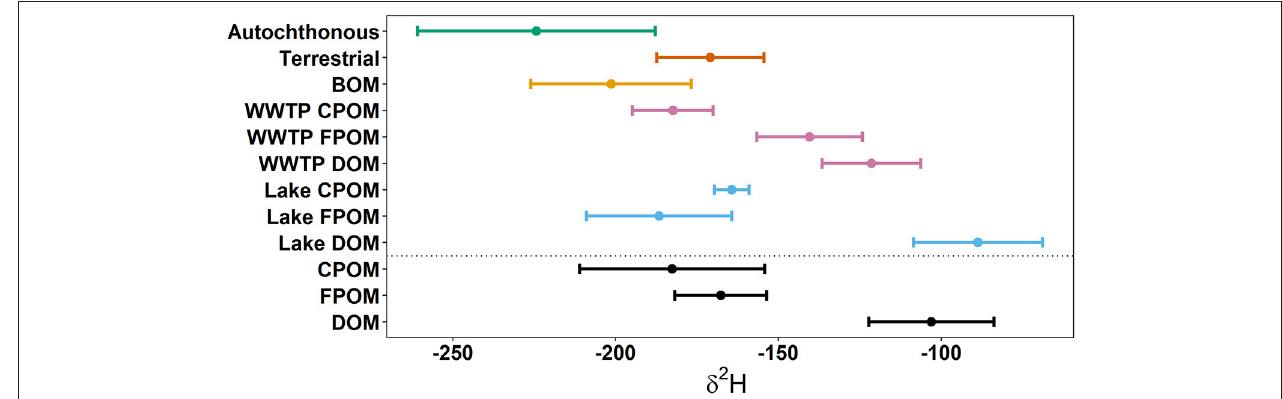
FIGURE 2 | Above the dotted line are average δ 2 H values of potential sources. Below the dotted are average δ 2 H values of three size-classes of organic matter. Dots represent the means and whiskers are 1 standard deviation. Autochthonous sources were the average of macrophytes, biofilms, and algae. Terrestrial sources were the average of senesced leaf-litter, living tree-leaves, and Phragmites ( Table 1 ).